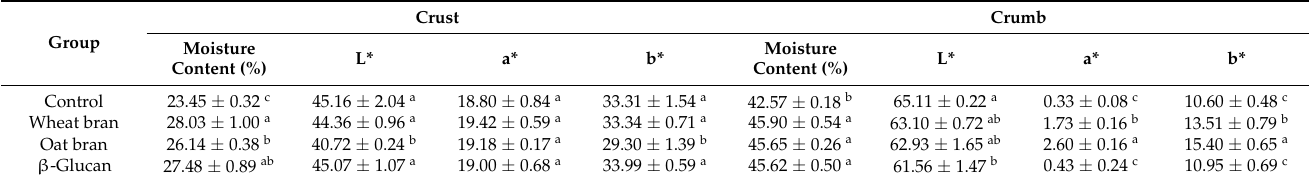
Table 3. Effects of different additives on the moisture content and color of bread crust and crumb.